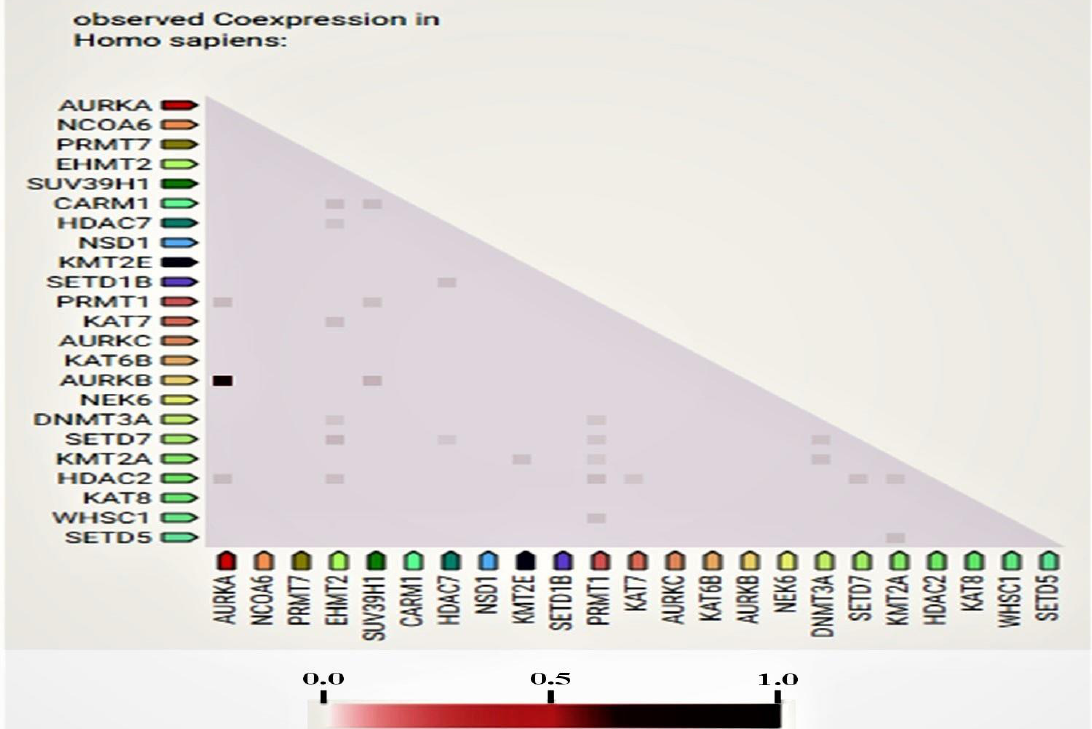
Figure 4. Proteins whose genes are observed to be correlated in expression across a large number of experiments. Co- expression scores based on RNA expression patterns and protein co-regulation provided by ProteomeHD.